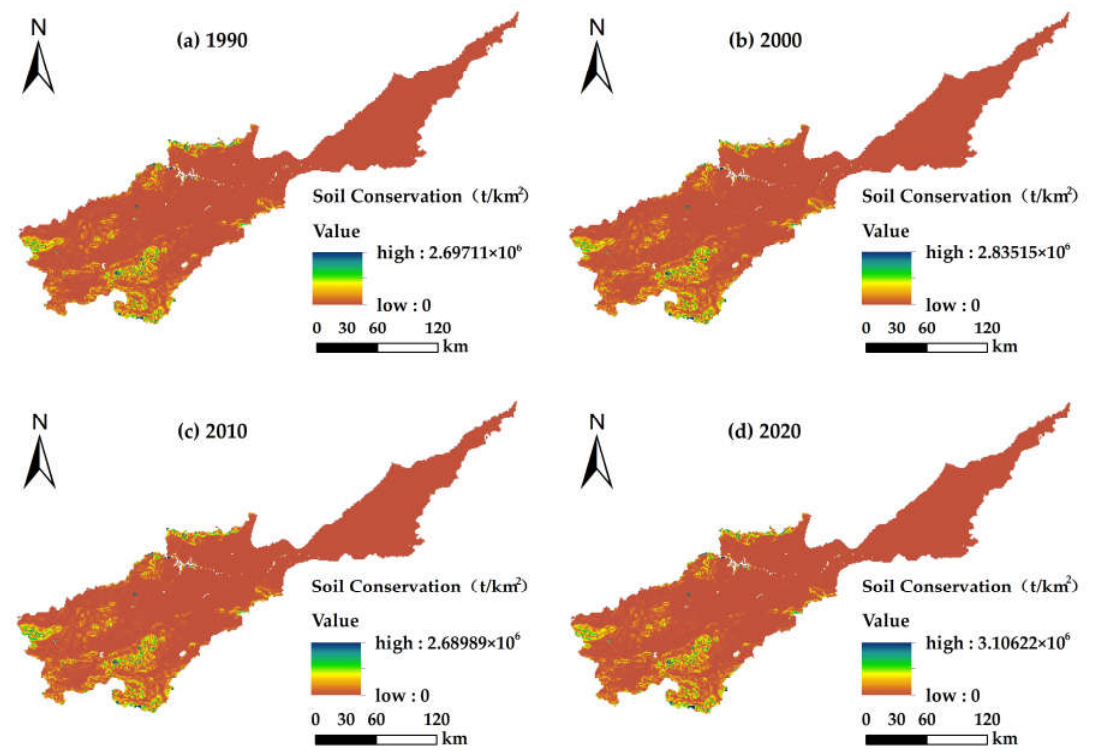
Figure 5. Spatial distribution for the average soil conservation for the Yellow River Basin (Henan section): ( a ) soil conservation map in 1990; ( b ) soil conservation map in 2000; ( c ) soil conservation map in 2010; ( d ) soil conservation map in 2020.